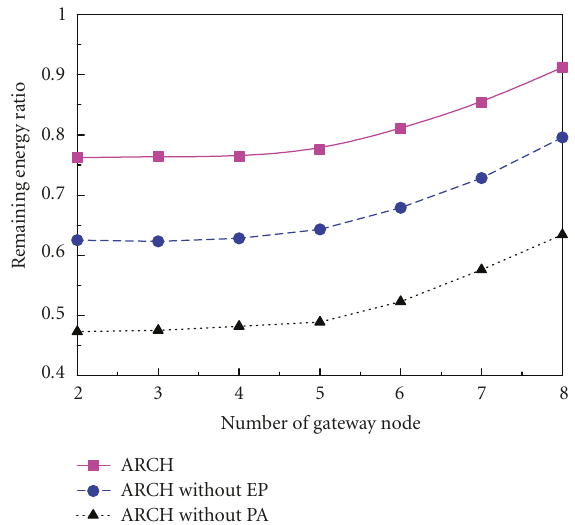
Figure 11: Remaining energy with di ff erent number of gateway